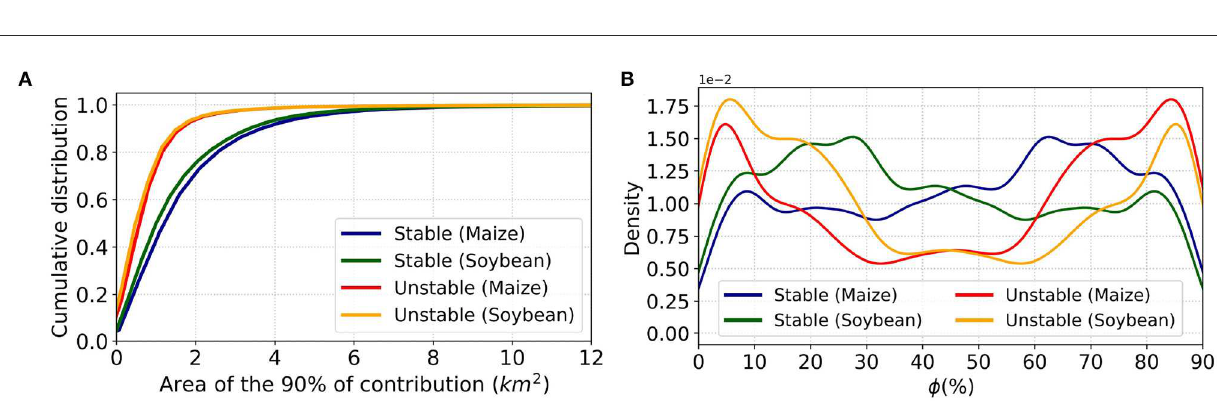
FIGURE9 Seasonal behavior of the relative flux footprint contributions due to maize and soybean fields from 2016 to 2019. The cumulative distribution of the (A) area of 90% of flux footprint contribution and the (B) probability density curves of relative flux footprint contributions ( φ ) show the behavior of each crop type under stable (blue and green, for maize and soybean, respectively) and unstable (red and orange, for maize and soybean, respectively) atmospheric